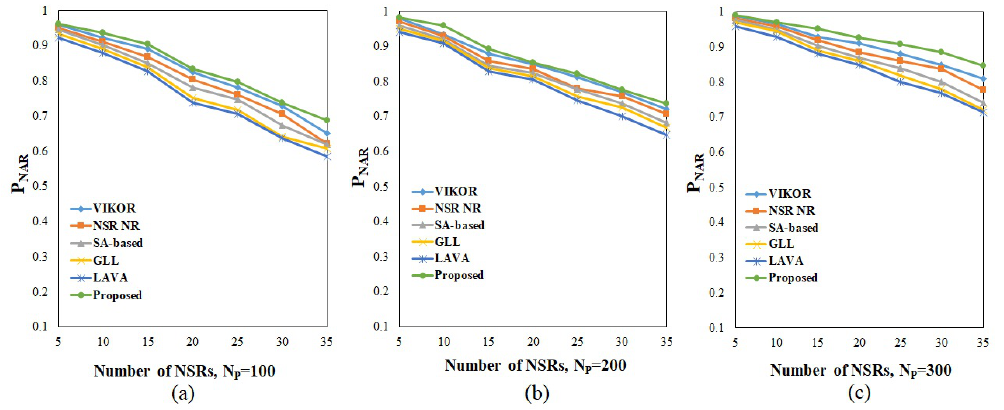
Figure 5. Acceptance Ratio under ( a ) 100, ( b ) 200, and ( c ) 300 nodes in physical infrastructure. Proposed method performance is compared with existing methods such as NSR-NR [19], SA [20], LAVA [21], GLL [22], VIKOR